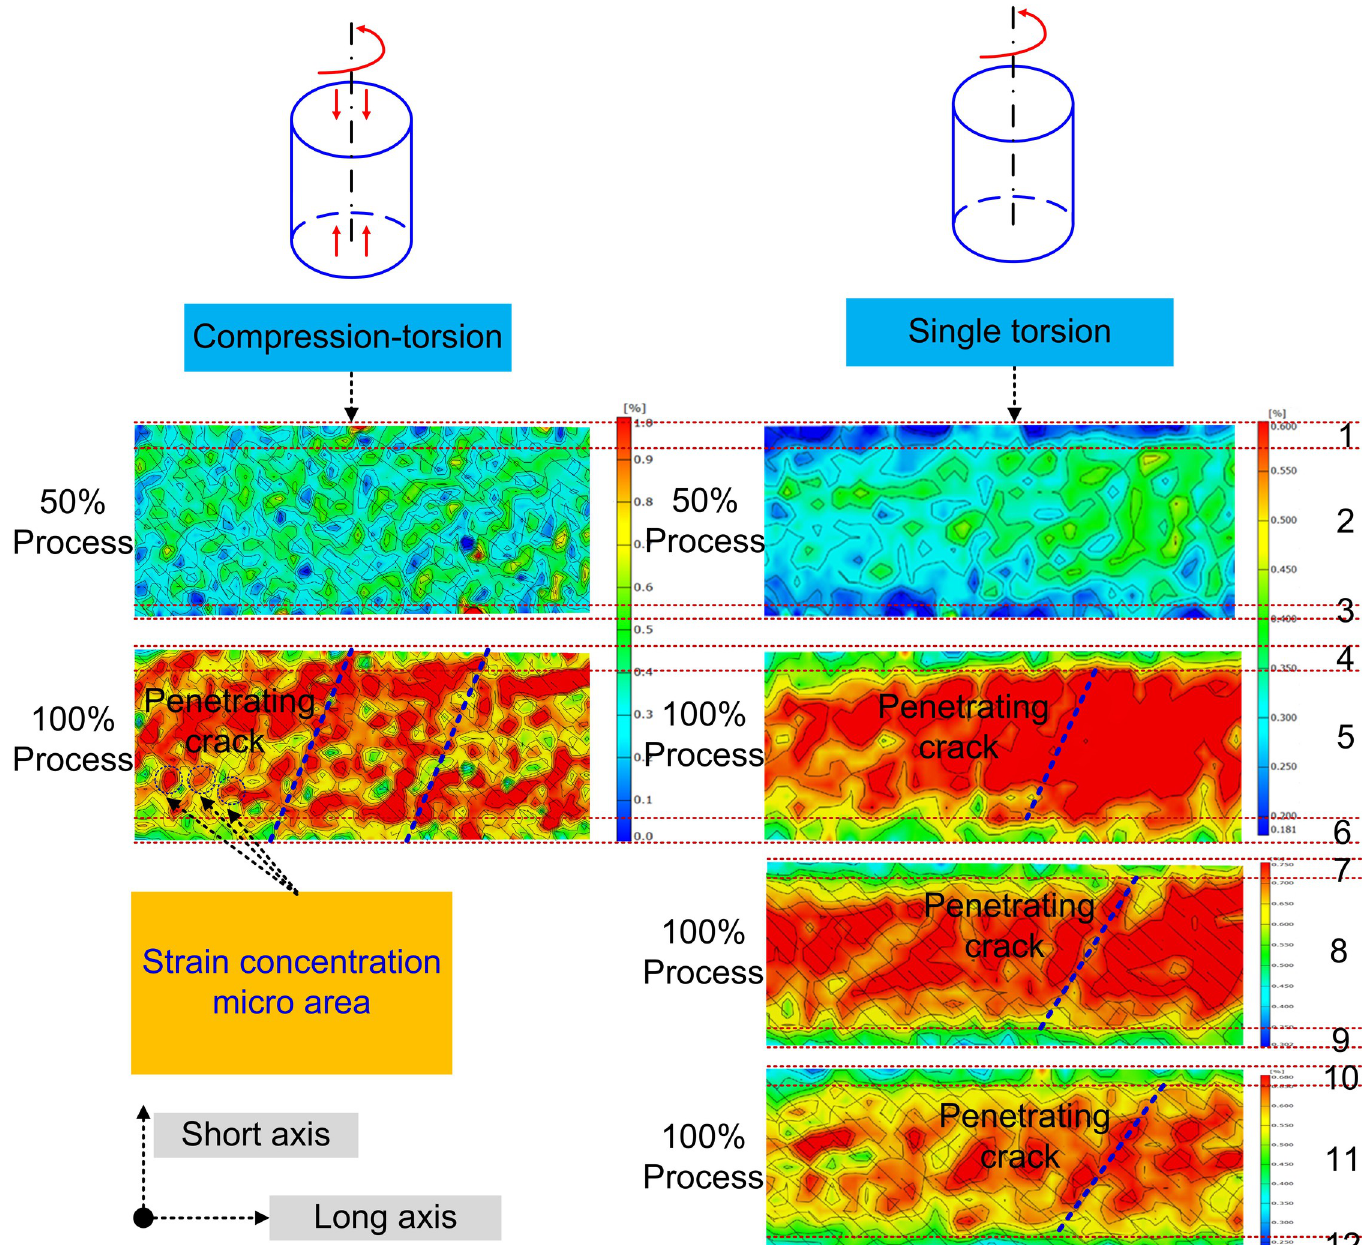
Fig 4. Principal strain contour of bone specimen under the compression-torsion coupling loads in different fracture stage (The distribution of the color of the strain contour was related to the spraying quality of the speckle, without affecting the revealing of the strain evolution mechanism. 1, 3, 4, 6, 7, 9, 10, and 12 are edge areas, 2, 5, 8 and 11 are the middle